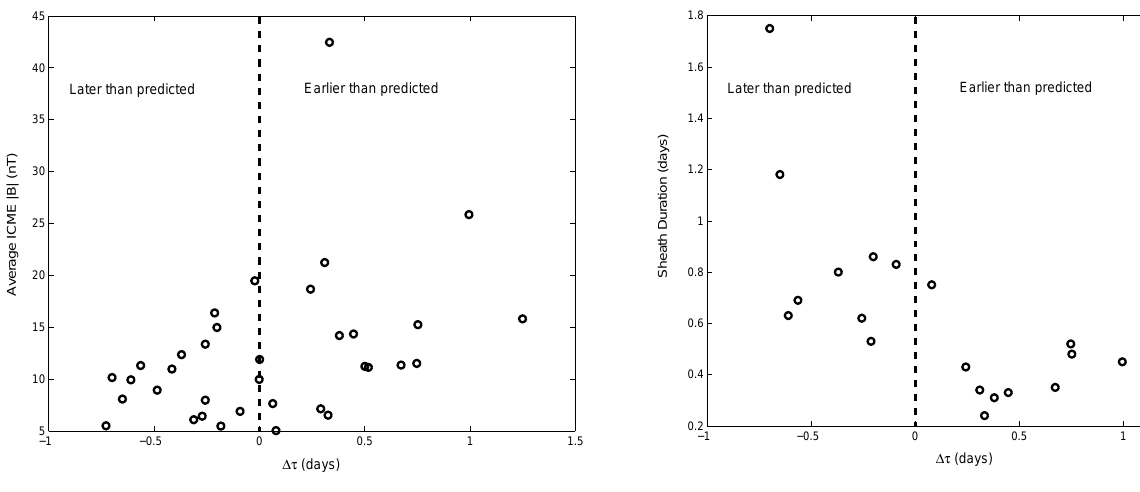
Fig. 6. Sheath region duration as a function of the difference be- tween the predicted and actual transit time to 1AU ( 1τ